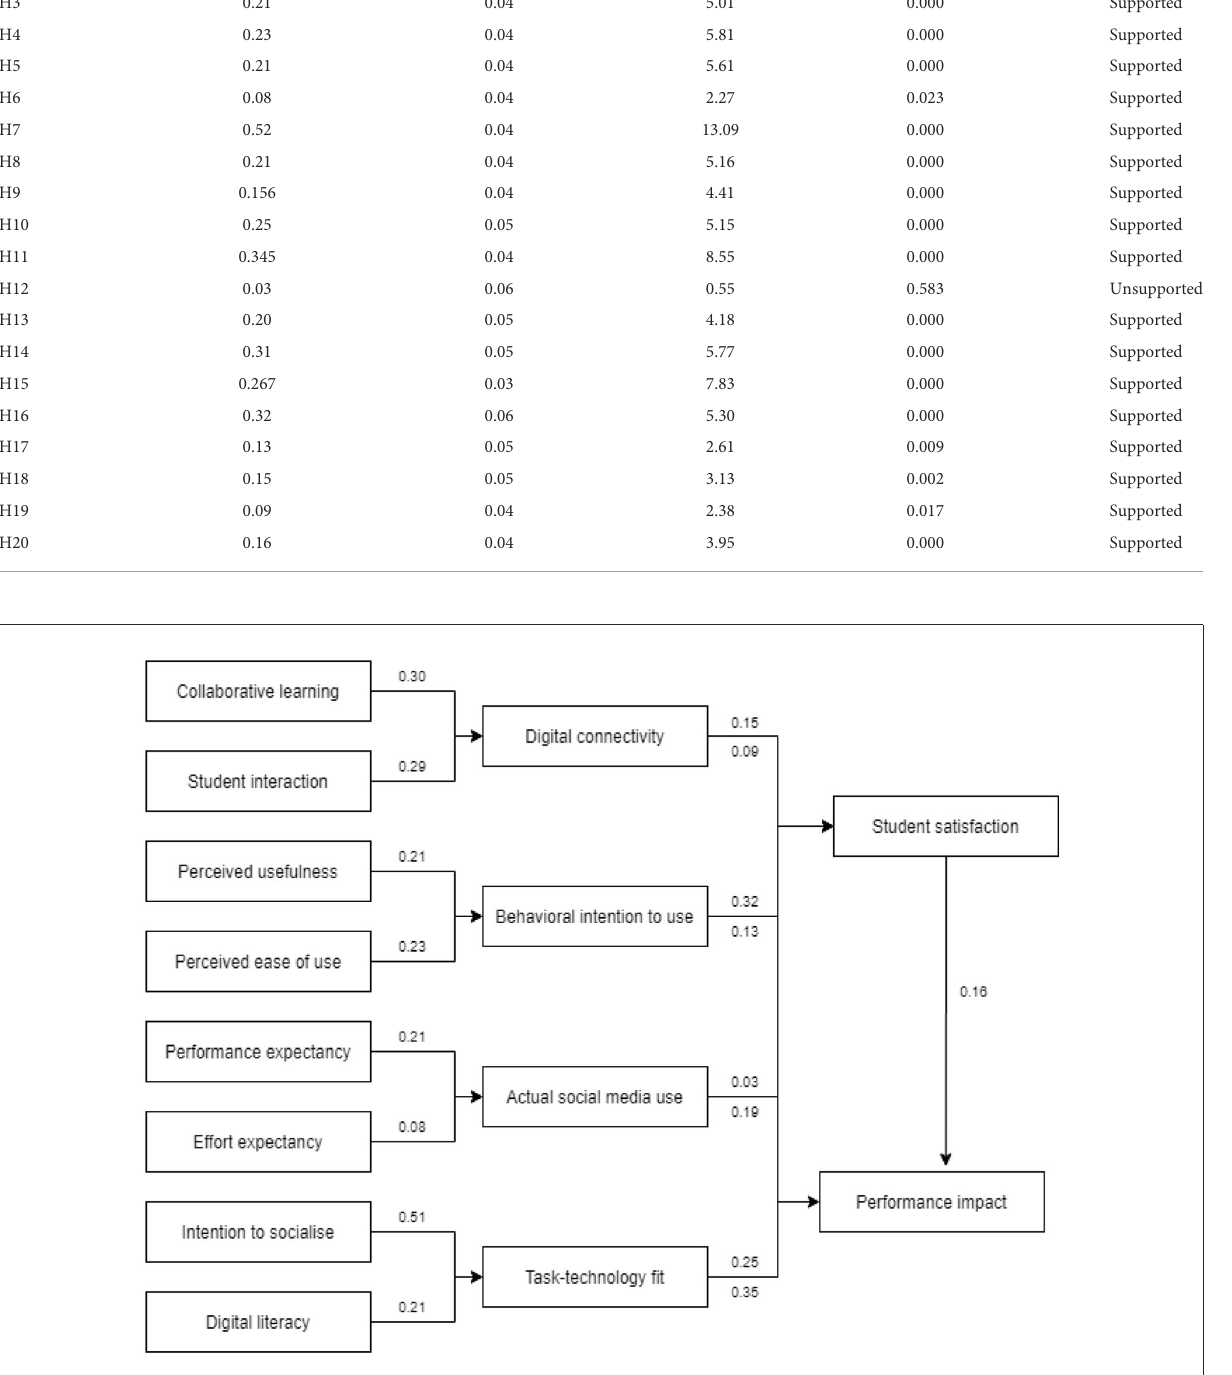
FIGURE2 Results for the proposed model of all student